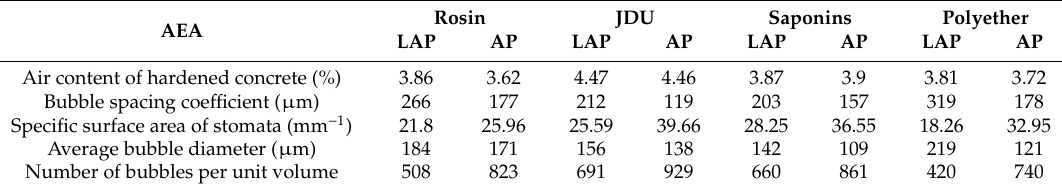
Table 7. Bubble characteristics of hardened concrete under di ff erent AP (similar air content).